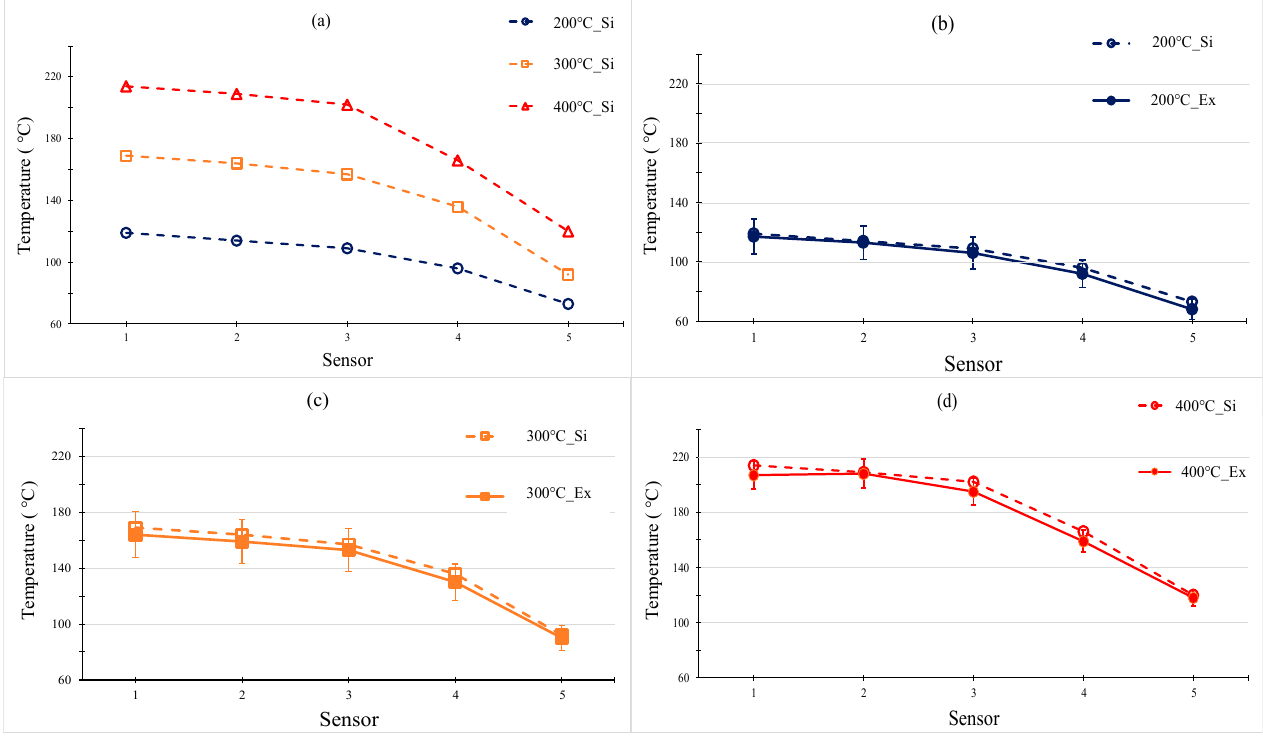
Figure 12. Temperature distribution of the cavity plate after 20 s of heating under different hot gas temperatures.